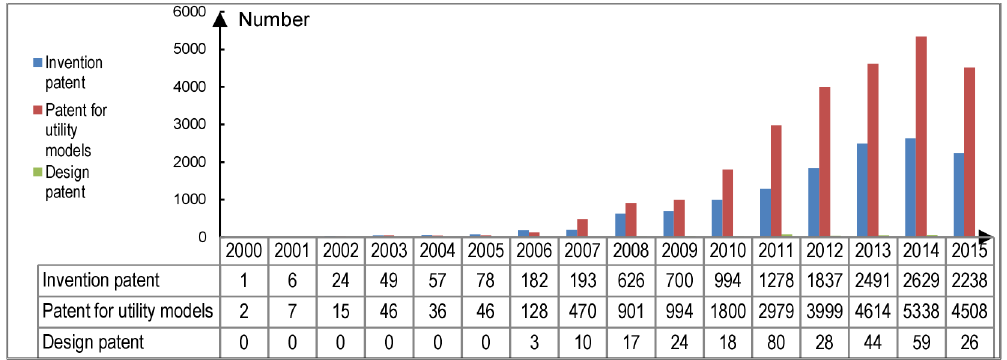
Figure 3. The number of different types of patent from 2000 to